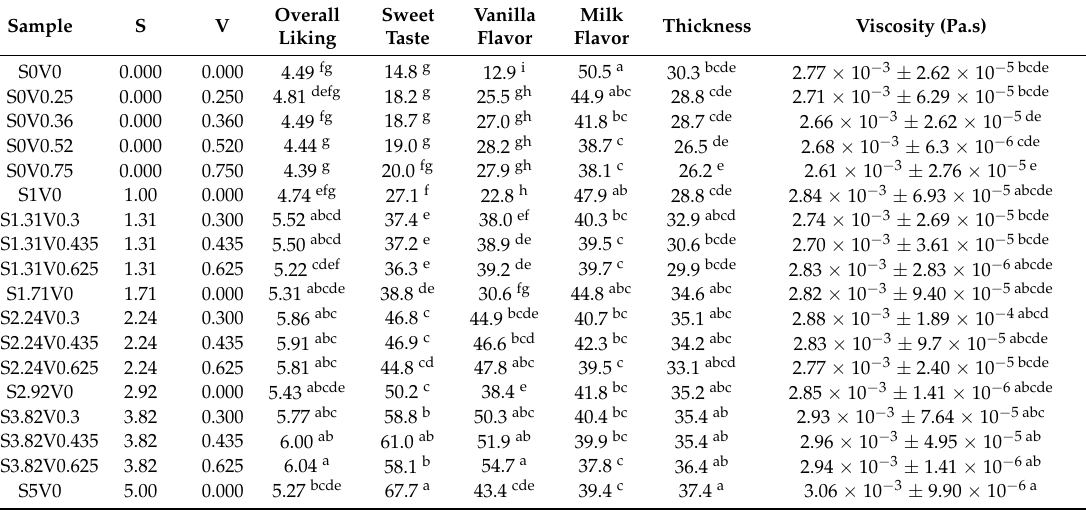
Same superscript letters in columns do not differ by Tukey’s HSD ( p <